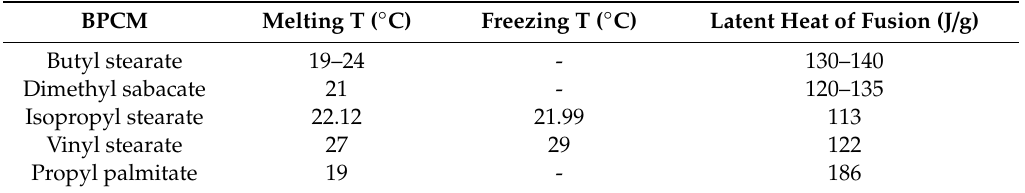
Table 3. Properties of some fatty acid esters suitable for the building application [2,4–6,22,39,40,51].